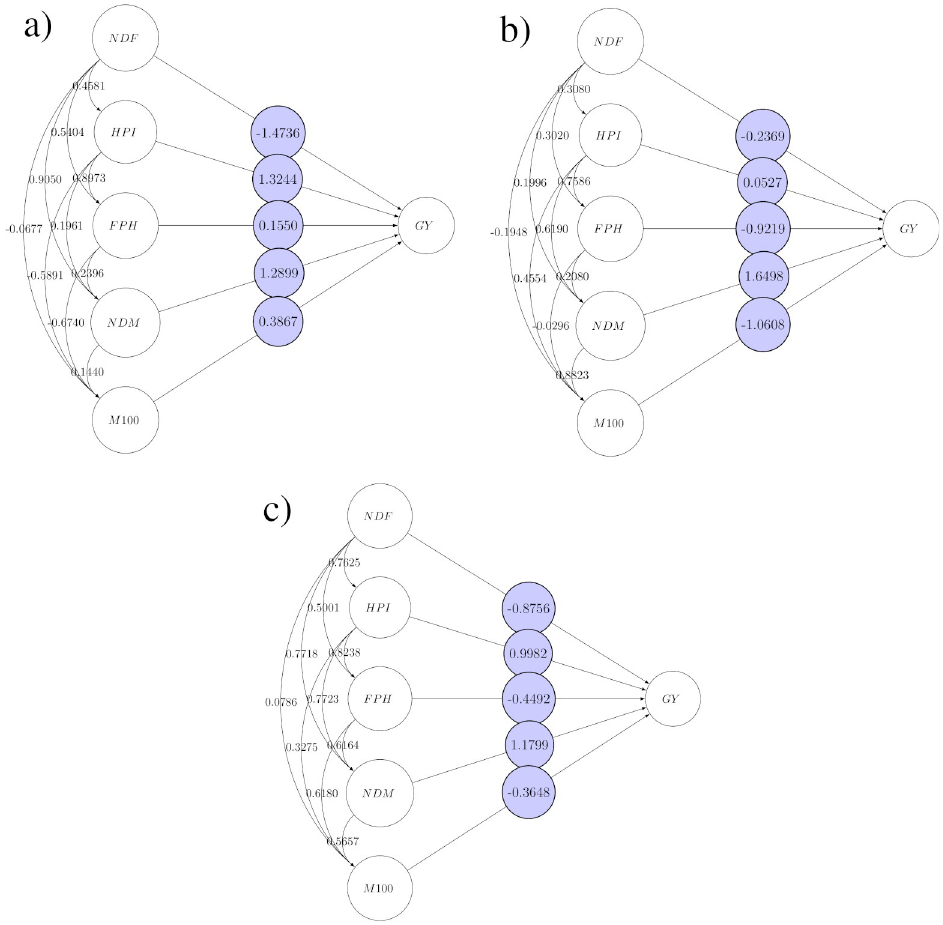
Fig 3. Diagram of path coefficients between the variables NDF, HPI, FPH, NDM, M100 and GY in tree mega- environments ((a) ME1, (b) ME2, and (c) ME3) used to test soybean genotypes.